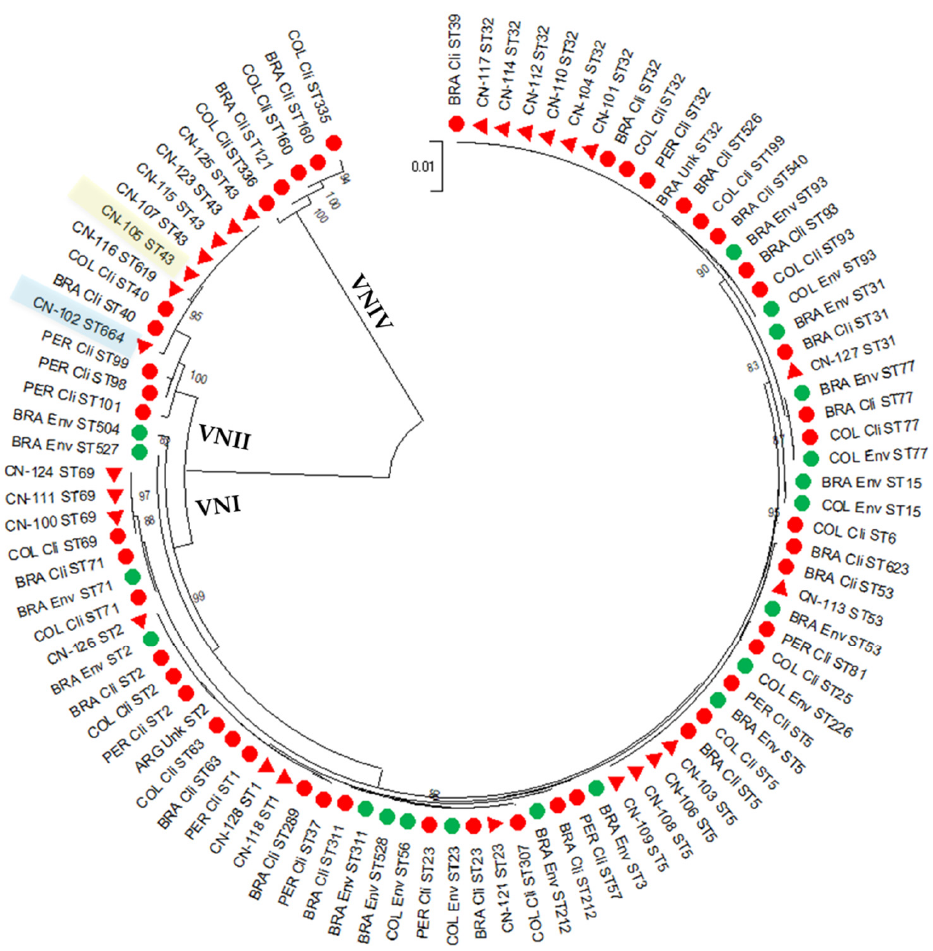
Figure 1. A dendrogram depicting the genetic relationship between clinical Cryptococcus neoformans isolates from this study (triangles) and other clinical (red) and environmental (green) isolates from Argentina (ARG), Brazil (BRA), Colombia (COL) and Peru (PER), as reported in former C. neoformans genotyping studies [10,18–23]. The VNII sequence types (ST), ST664, newly identified, and ST43, belonging to an isolate from a 9-year-old girl, are highlighted in blue and yellow, respectively. The dendrogram is based on the analysis of the seven concatenated ISHAM consensus MLST loci using the program MEGA 11 [24]. Bootstrap values above 75 are indicated on the